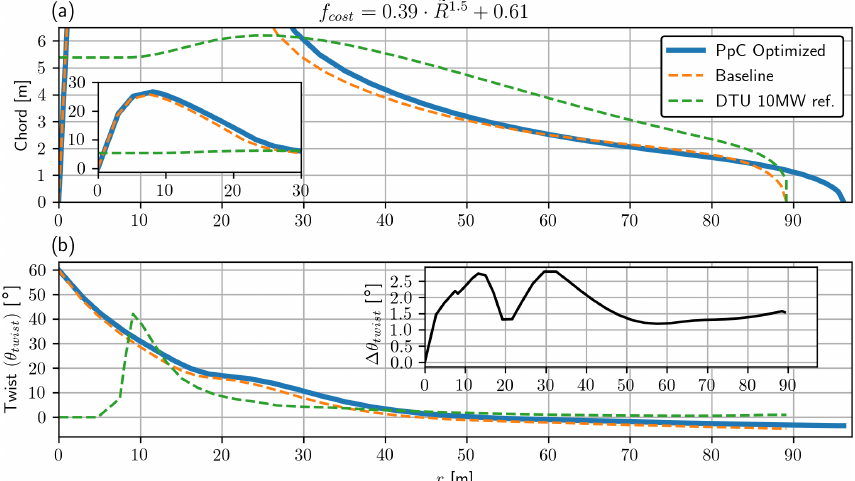
Figure 9. (a) Blade chord and (b) blade twist, both as a function of rotor radius ( r ) for the optimized rotor. In panel (a) an insert is added showing the chord from 0–30m. In (b)) an insert is added which shows the difference in twist between the baseline and the PpC-optimized rotor ( (cid:49)θ twist = θ PpCopt . − θ Baseline